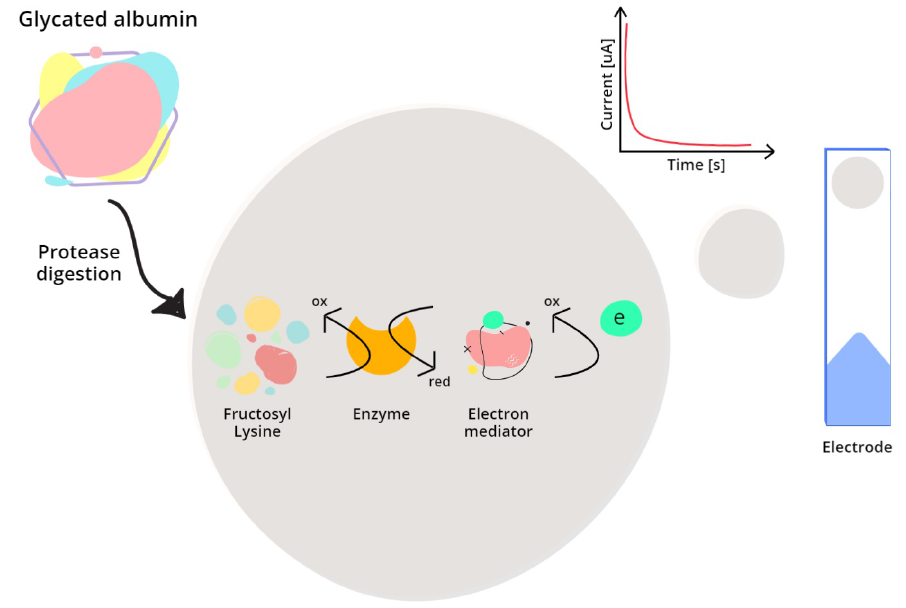
Figure 3. Schematic process of an electrochemical enzymatic analysis of glycated albumin. Initially, the sample has to undergo a proteolytic digestion to release (cid:101) -FK from GA. Then, a specific enzyme (FAOX) oxidizes this substrate while simultaneously an electron mediator is reduced. Finally, by applying an appropriate voltage potential at the electrode site, the reduced-form mediator is oxidized back, releasing electrons that can be collected to measure a